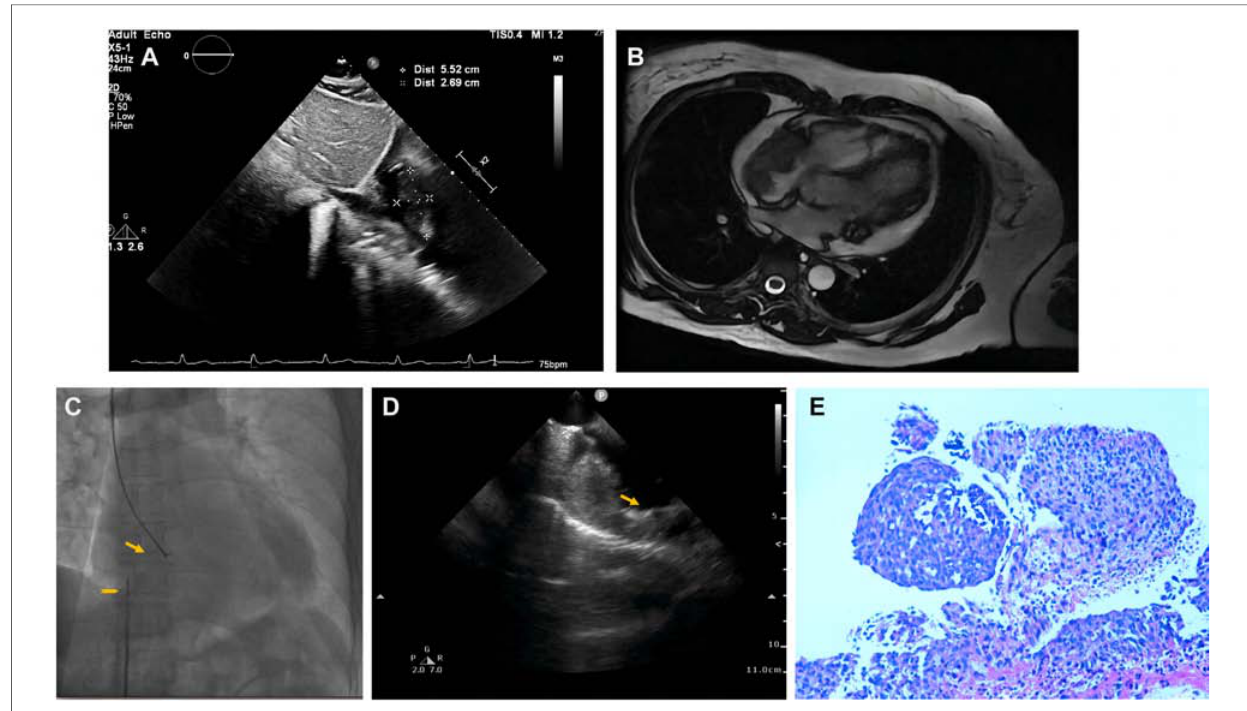
FIGURE 4 Multimodality images and intracardiac echocardiography-guided biopsy of cardiac tumors of Case2. ( A ) Transthoracic echocardiography showed a huge mass lesion in the RA. ( B ) Cardiac enhanced-MRI revealed a large irregular mass (55.2×38.1×33.9 mm) with a rounded appearance in the RA and connected with the right atrium. ( C ) Catheter for intracardiac echocardiography (arrowhead) and cardiac bioptome(arrow). ( D ) The intracardial echocardiography demonstrates thickness mass of the right atrium and well-targeted biopsy catheter (arrow) on the mass. ( E ) Histopathological diagnosis revealed cardiac angiosarcoma, with spindle tumor